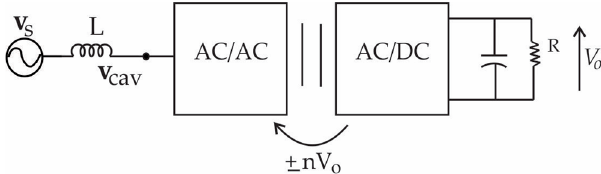
Table 1. Switching states vectors of matrix converter. Figure 10. Generalized diagram for steady-state analysis